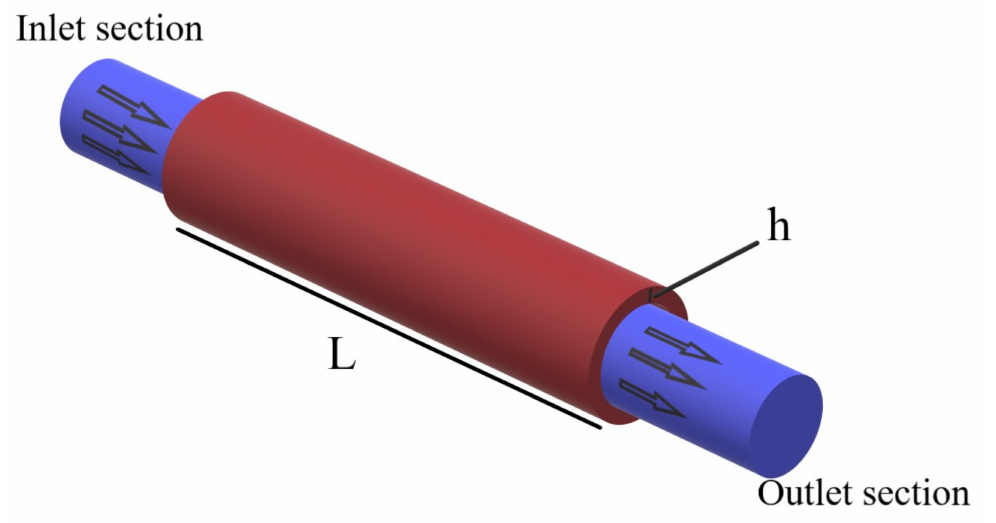
Figure 1. Schematic of fluid conveying MWCNT-reinforced nanocomposite